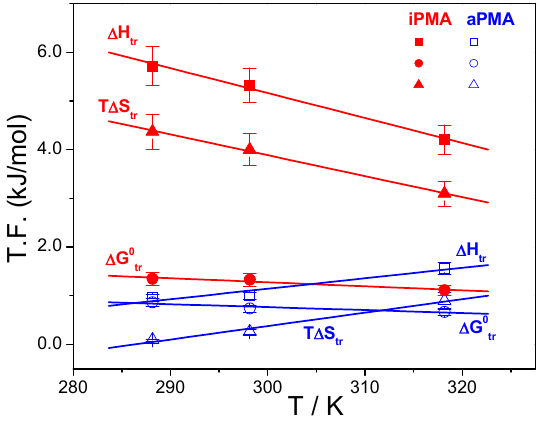
Figure 7. Thermodynamic functions (T.F.) accompanying the transition of iPMA and aPMA chains from the uncharged ( α = 0) to the charged state ( α > 0, above the conformational transition).